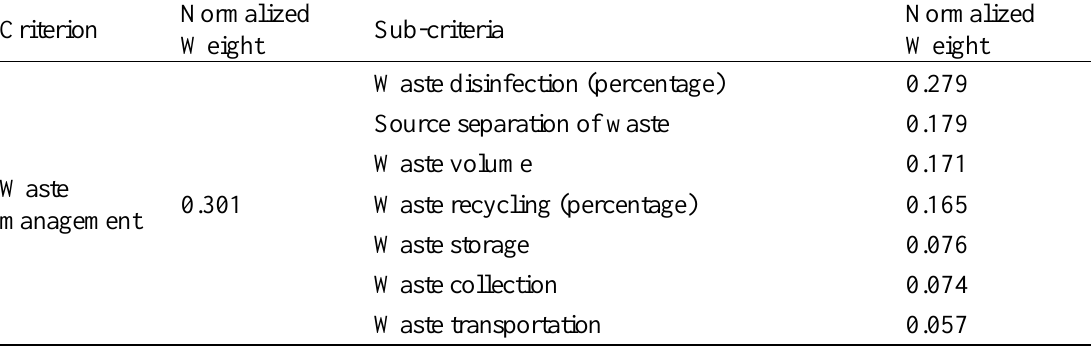
Table 2. Waste management sub-criteria and corresponding weights